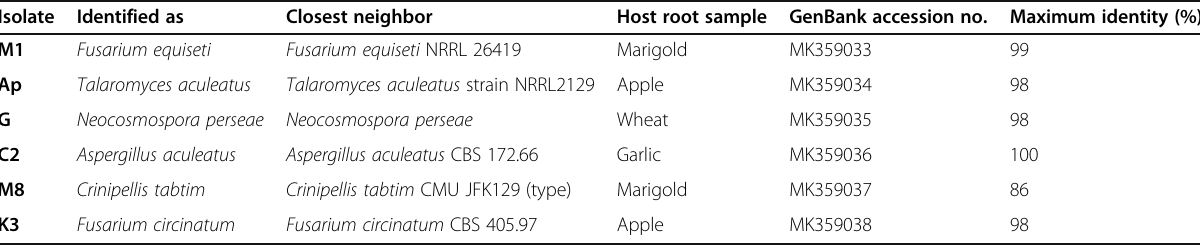
Table 1 Identification of fungal root endophytes isolated from apple and other